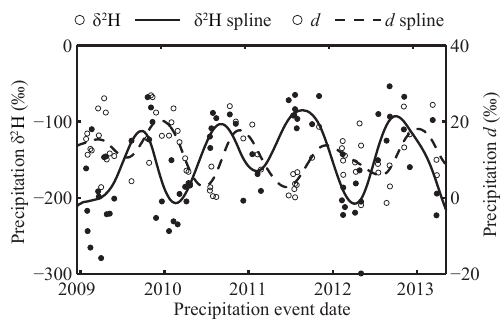
Figure 7. Annual maxima and minima in deuterium excess, d , lag those of δ 2 H by 2–3 months, such that the maxima are in fall and minima in